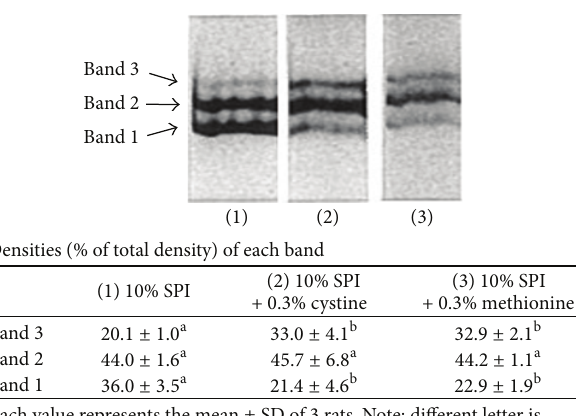
Figure 3: Molecular diversity of liver G6PD separated after elec- trophoresis on 7.5% polyacrylamide slab gel. Cytosol samples with 5 mU equivalent G6PD activity were applied on the gels and stained for G6PD activity after electrophoresis. Lanes (1), (2), and (3) represent 10% SPI, 10% SPI + cystine, and 10% SPI + methionine, respectively. Bands 1, 2, and 3 represent fully oxidized, partially oxidized, and fully reduced forms. Different letters in bands show significant difference ( 𝑝 < 0.05 ).